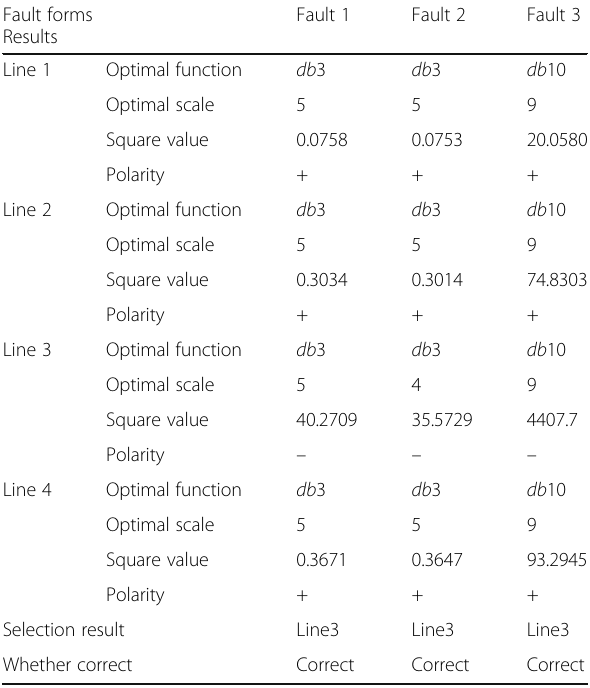
Table 1 Simulation results based on